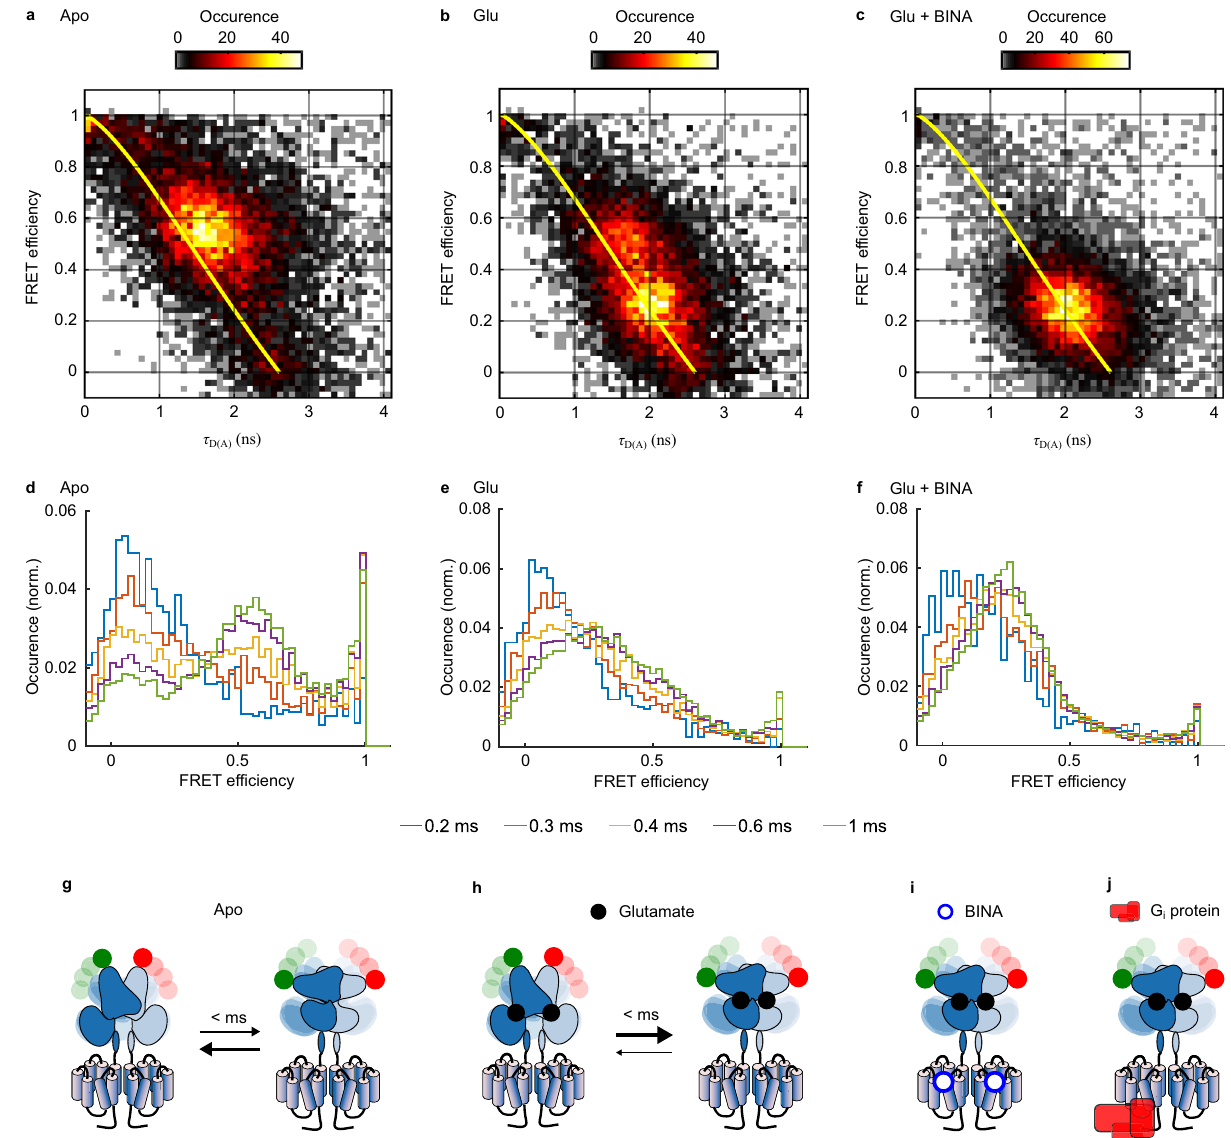
Fig. 4 Structural dynamics analysis of mGlu2 dimers in response to orthosteric and allosteric ligands. a – c Representative τ DA vs. E histogram for mGlu2 dimers in the absence (Apo) or presence of Glu or Glu + BINA. For the Apo receptors, the major population deviates from the “ Static FRET ” line (yellow), indicating conformational dynamics at the submillisecond time scale. The addition of Glu stabilizes the VFT in an ensemble of low FRET conformations with less fl exibility, an effect that is reinforced by the allosteric modulator BINA. d – f Time window analysis for different integration times (from 0.2 – 1 ms) reveals large conformational fl exibility of the Apo VFT at 200 – 600 µ s timescales, which is strongly restricted when bound to orthosteric agonist and allosteric modulator. The number of data points used varied from 2183-1640-901 ( d – f respectively, 200 µ s) to 14082-13132-13269 (1 ms) g – j Schematic representation of the major species observed in all cases, with the timescales of the transition between them. Black and blue dots represent Glu and BINA, respectively. Source data of panels a – f are provided upon